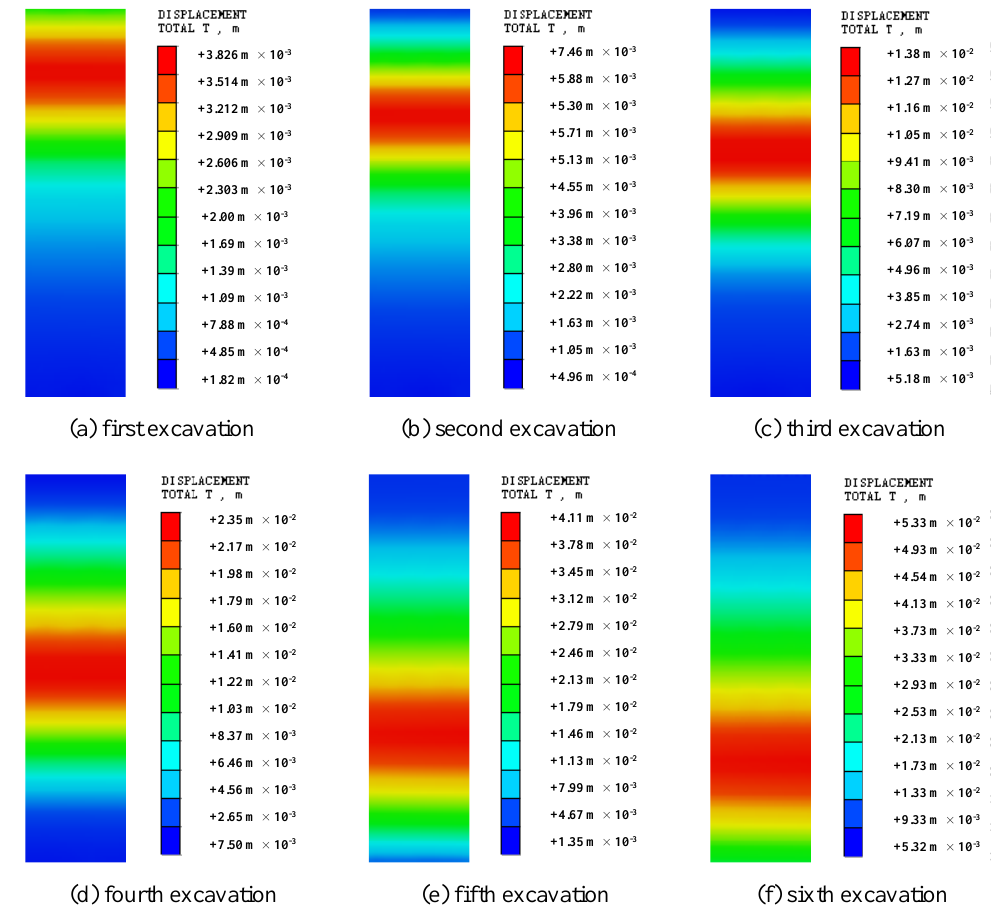
Figure 18. The cloud of horizontal displacement of foundation pit excavation enclosure structure without seepage point.